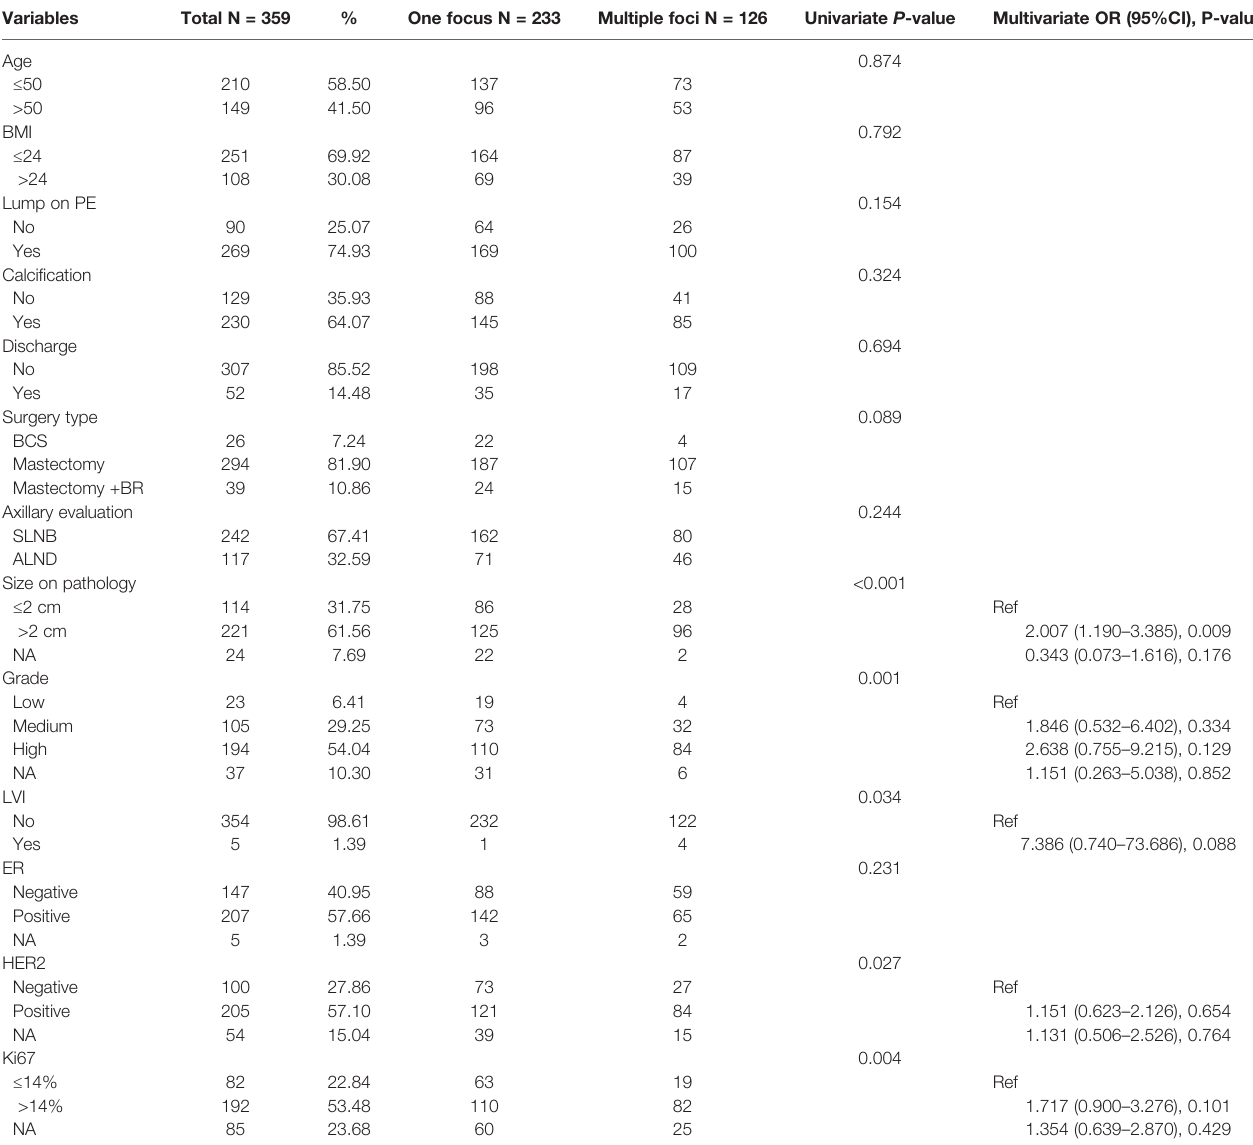
TABLE 1 | Baseline characteristics, univariate and multivariate analysis of clinicopathological factors in DCISM patients with one focus and multiple foci. Variables Total N =